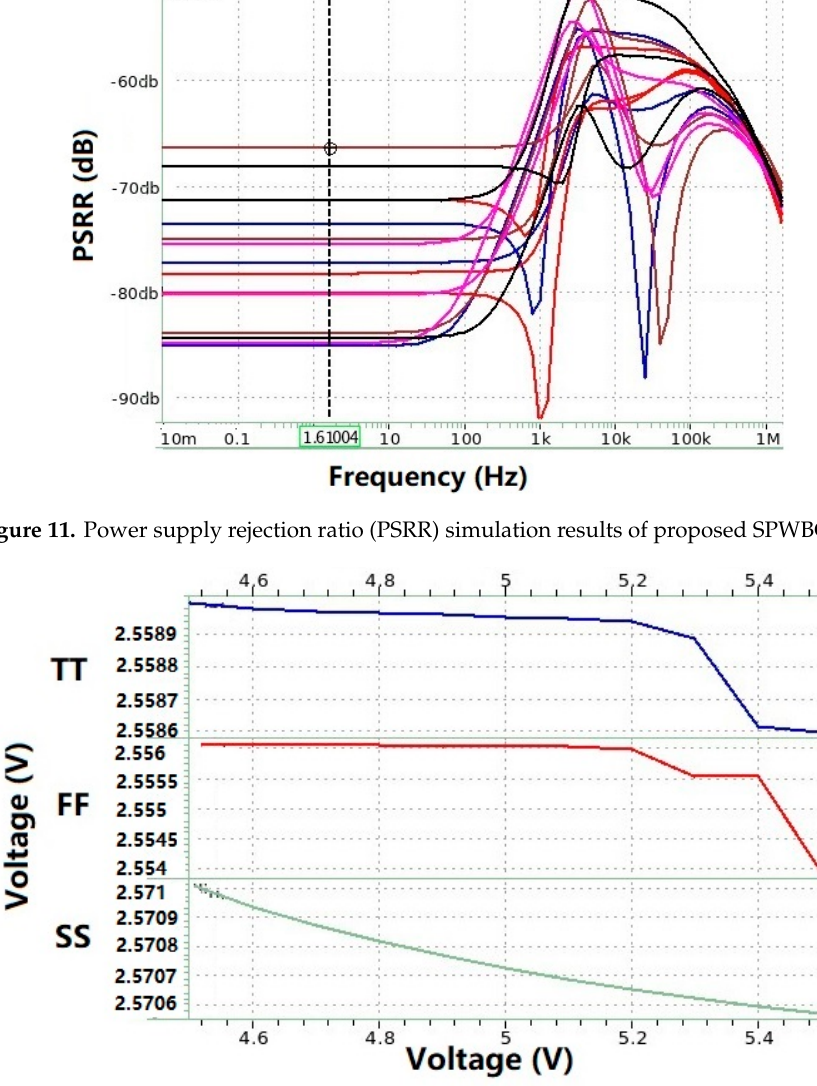
Figure 12. Line Regulation simulation results of the proposed bandgap reference (BGR).